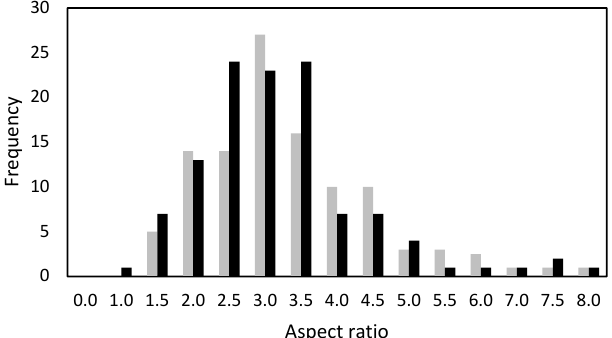
Figure 11. Distribution of the aspect ratios for the {110} planes in the 40–80 µ m (grey) and 80–150 µ m (black) fractions.